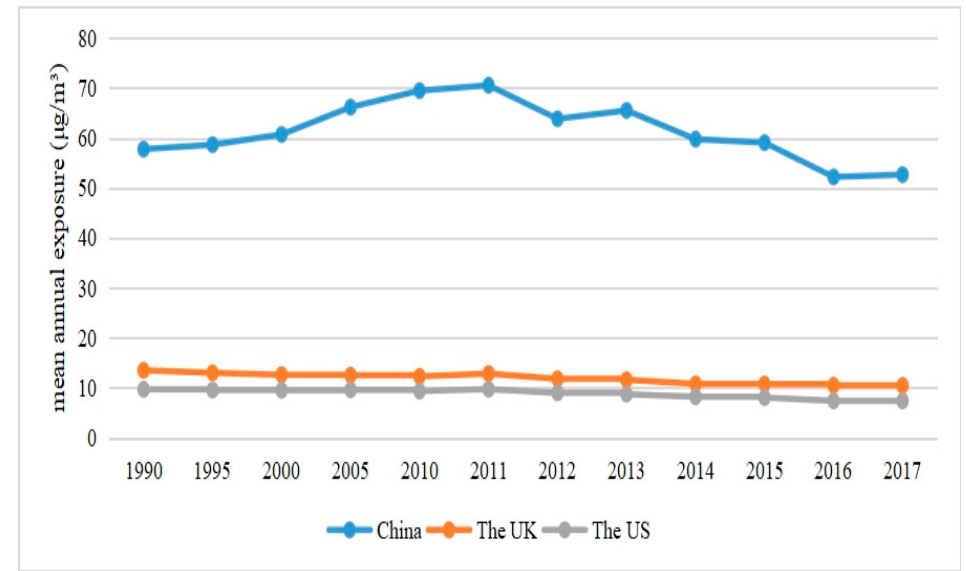
Figure 1. 1990–2017 China, the UK, and the US Population-weighted average level of exposure to PM 2.5 (mean annual exposure ( µ g/m 3 )). Data source: World Bank/ourworldindata.org